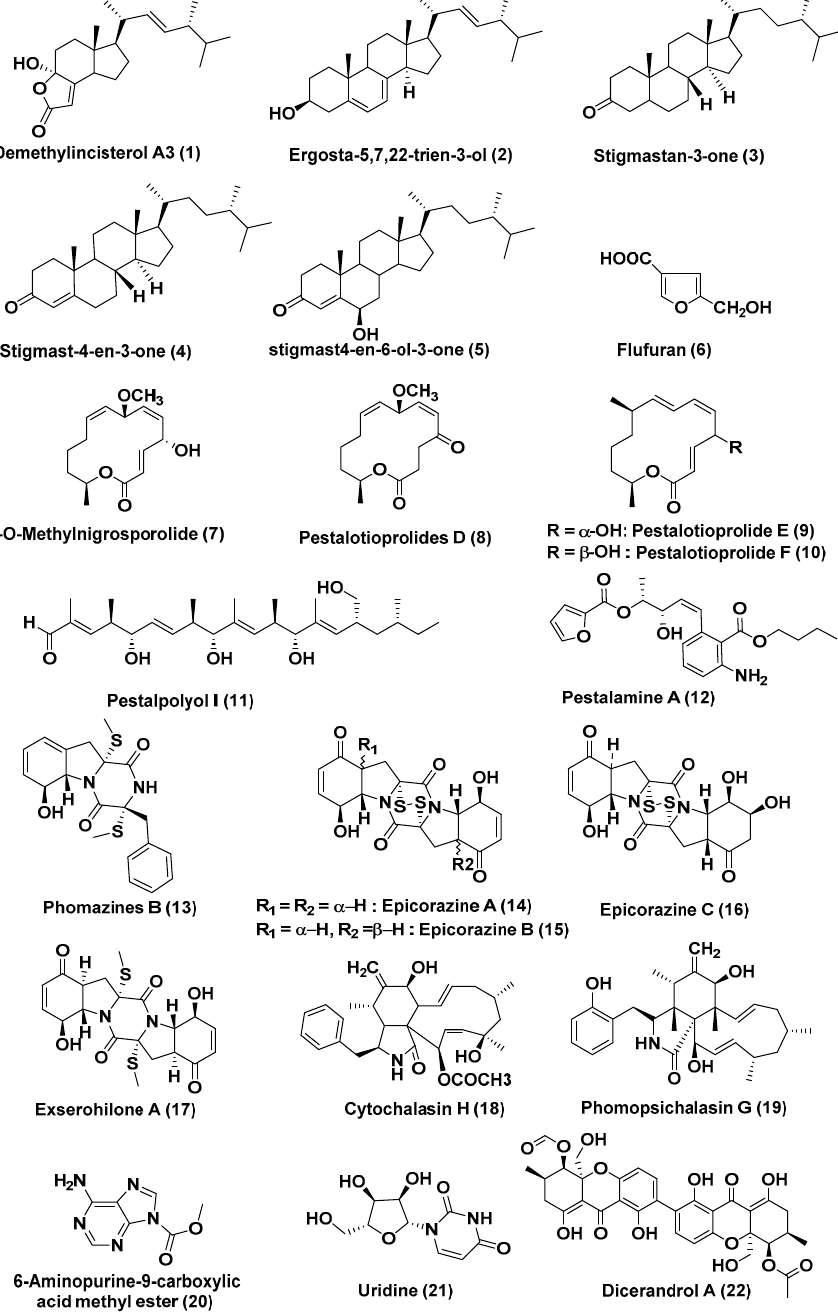
Figure 2. Structures of metabolites isolated from Coelomycetes ( 1 – 22 ).